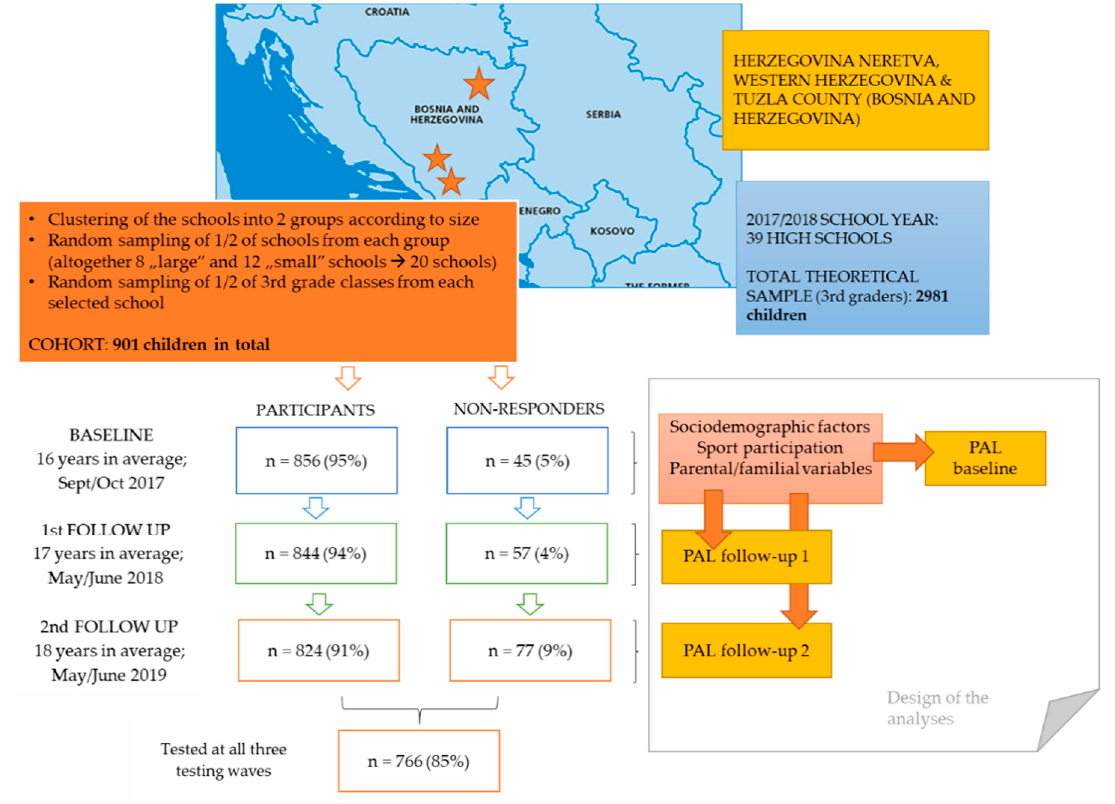
Figure 1. Study location, design, and testing sequences.